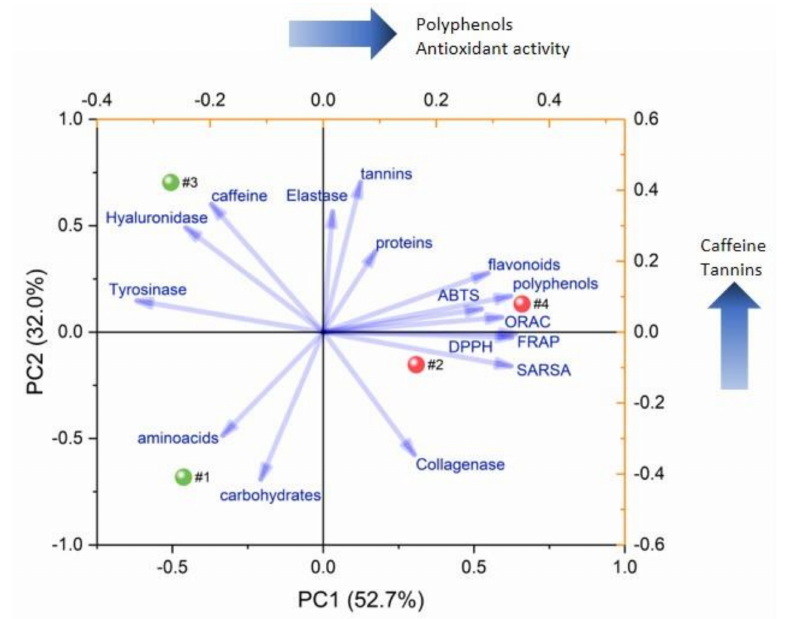
Figure 3. PCA biplot. Blue vector for loadings of Table S2 variables; sample scores represented as dots and labeled as: #1 = ripe pu-erh aqueous extract; #2 = raw pu-erh aqueous extract; #3 = ripe pu-erh hydro-alcoholic extract; #4 = raw pu-erh hydro-alcoholic